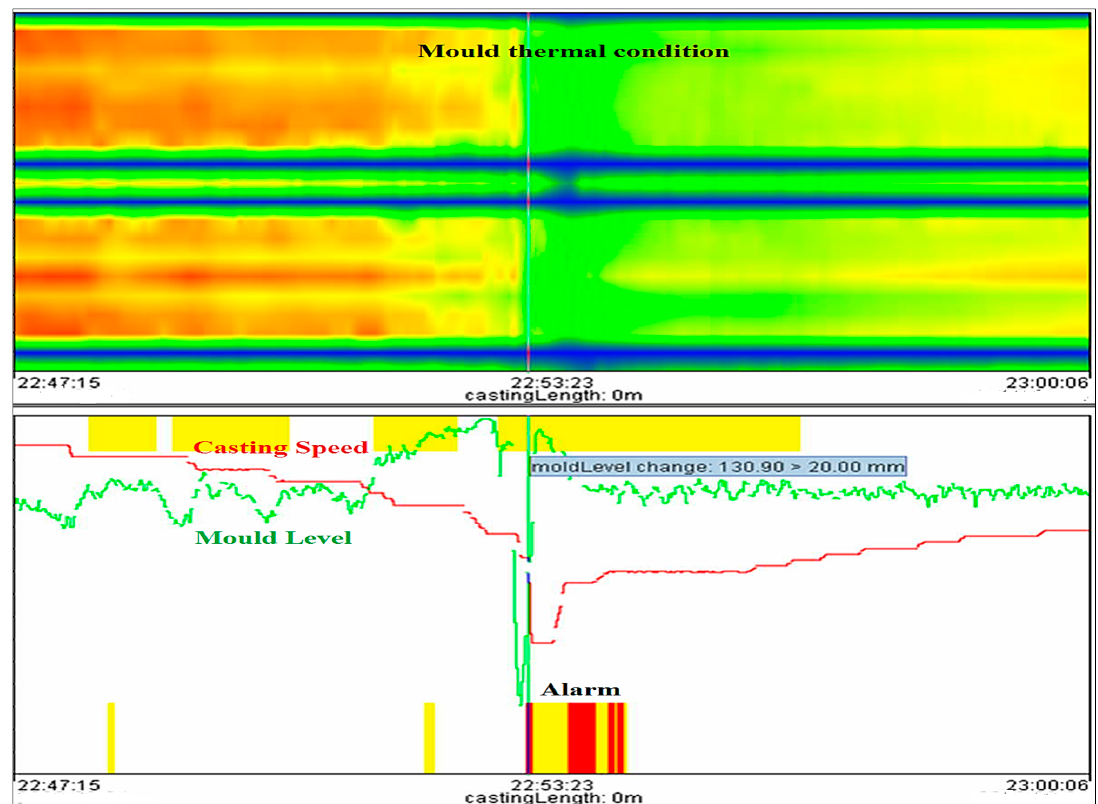
Figure 13. Breakout alarm due to variation in mold level during unstable casting condition.